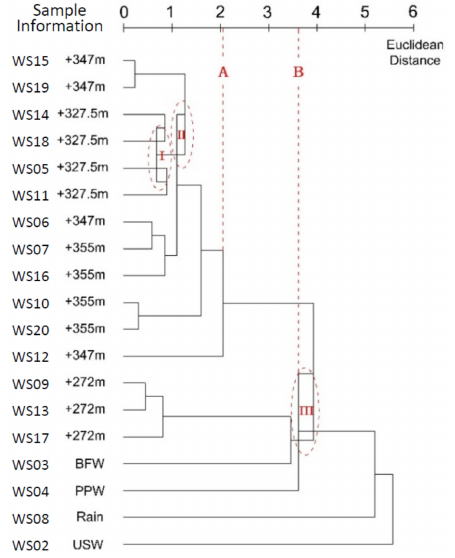
Figure 9. Dendrogram of data through median